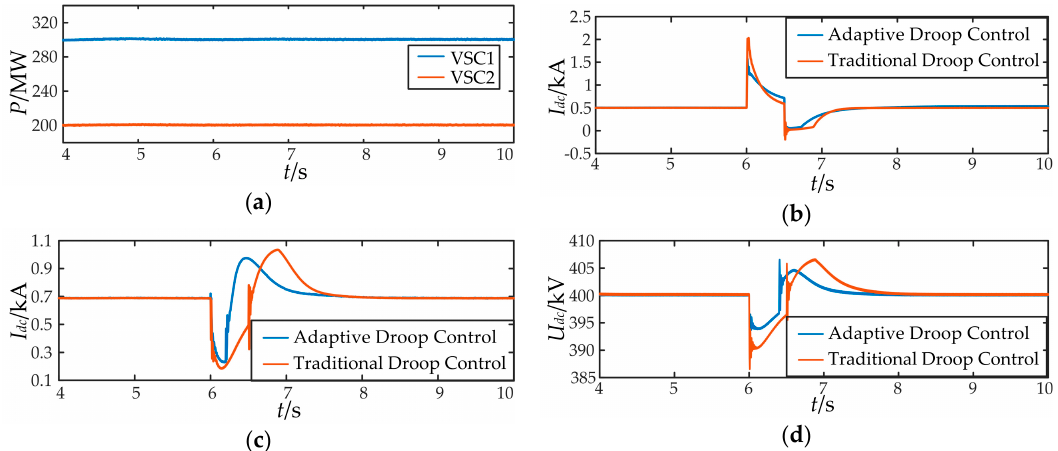
Figure 16. Simulation waveforms of the three-phase short circuit fault in the AC grid on the LCC3 side: ( a ) Active power of VSC1 and VSC2; ( b ) DC current of LCC3; ( c ) DC current of LCC4; ( d ) DC voltage.